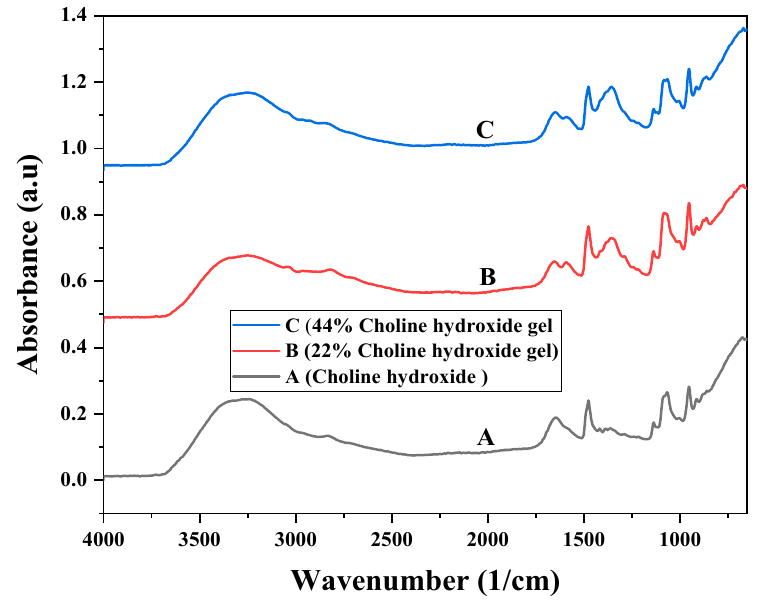
Figure 1. FTIR spectra of (A) 44% choline hydroxide ionic liquid, (B) 44% choline hydroxide ionic liquid gel, and (C) 22% choline hydroxide ionic liquid